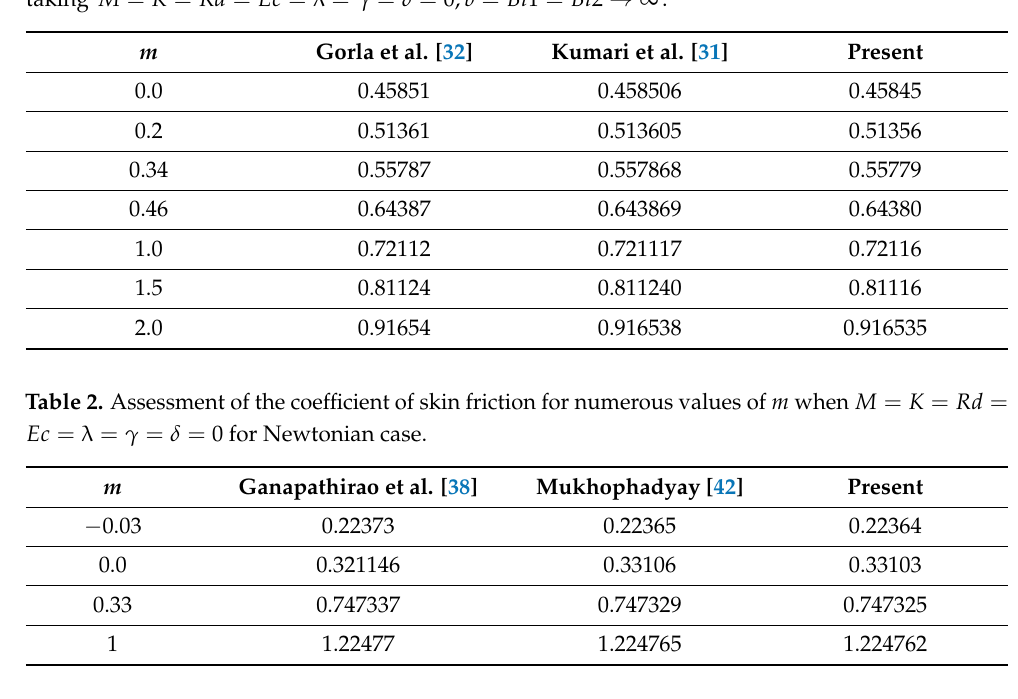
Table 1. Assessment of the coefficient of skin friction for numerous values of m when Pr = 6.2 by